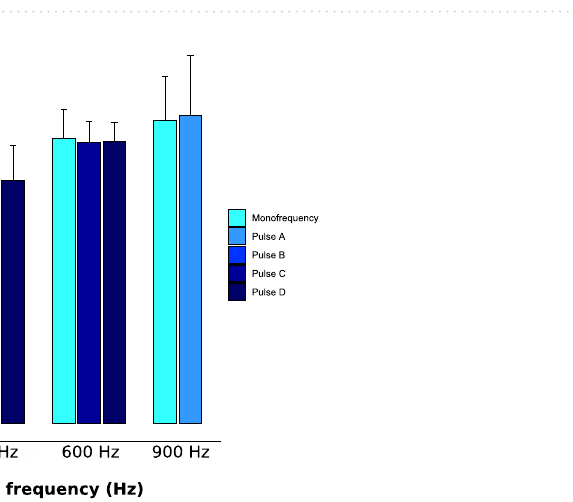
Figure 5. ( a ) Phase and ( b ) magnitude images of the composite excitation 300 Hz and 600 Hz acquired with the OC pulse C. ( c ) Then separated phase images (rad) of every frequency component extracted after temporal Fourier transform, choice of the corresponding harmonics and application of the inverse Fourier transform: top: 300 Hz; bottom: 600 Hz. ( d ) G ′ elastograms (kPa) reconstructed for each frequency component: top: 300 Hz; bottom: 600 Hz. The ROIs used for the computation of the shear storage modulus mean and standard deviations are shown with red lines on the maps in ( c ).